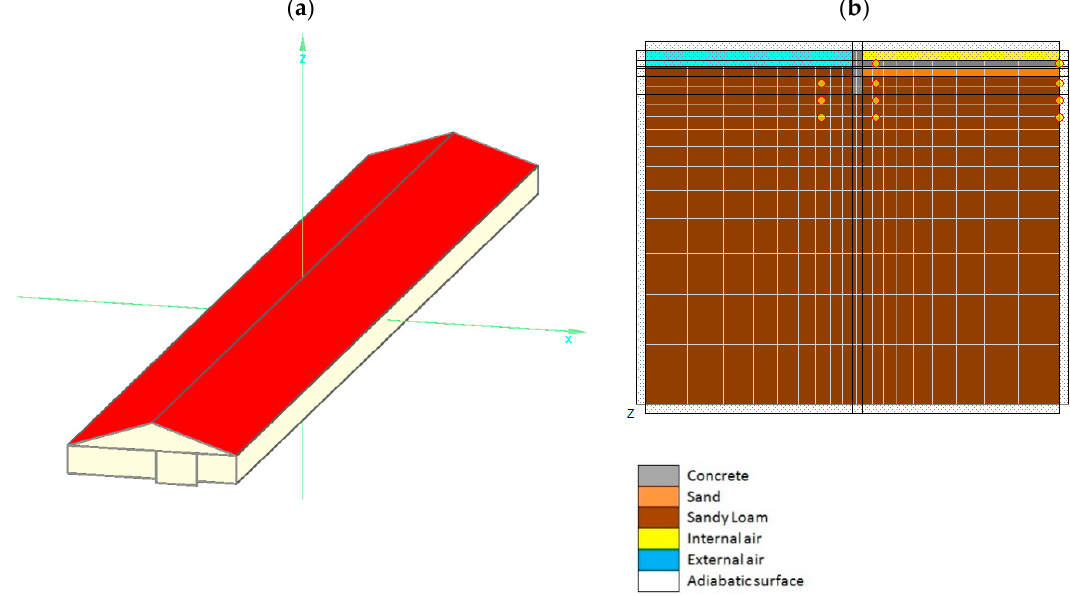
Figure 2. Broiler house model ( a ) and the grid of soil temperature measurement points ( b ).